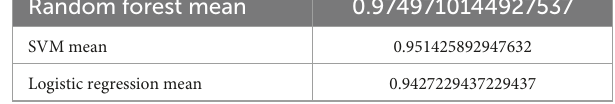
TABLE 2 Mean f1 scores in testing in-house data.